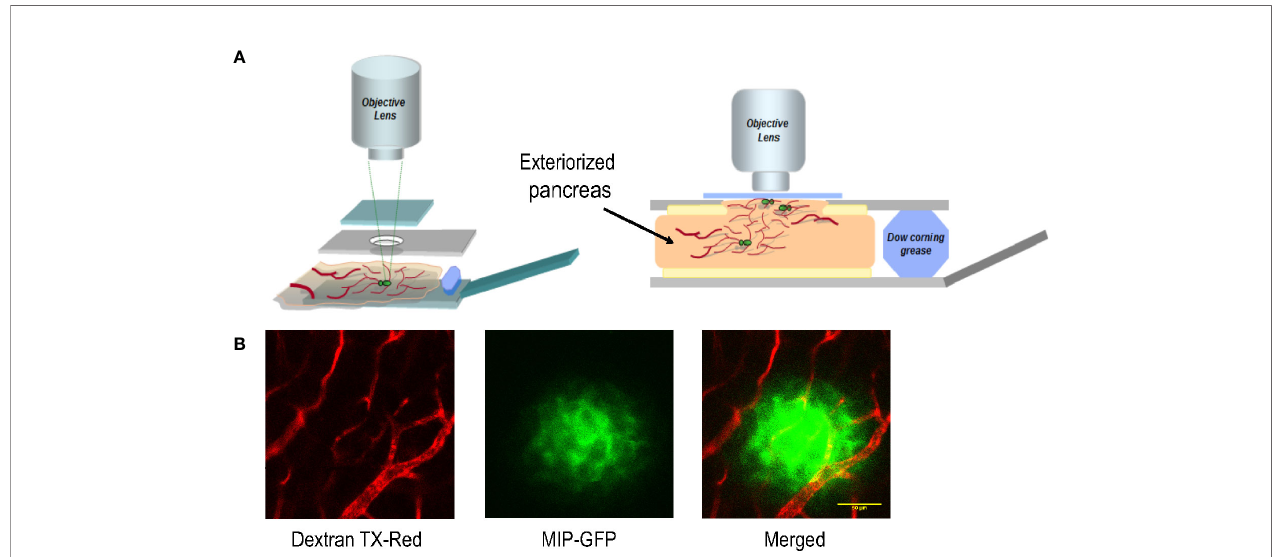
FIGURE 1 | The platform for imaging islet cells in the intact pancreas of a live mouse. (A) Schematic of the customized imaging reservoir for housing the exteriorized pancreas for intravital imaging. (B) Example images showing blood vessels surrounding and within an islet of a MIP-GFP mouse. Dextran TX-Red was delivered through tail vein injection to label the